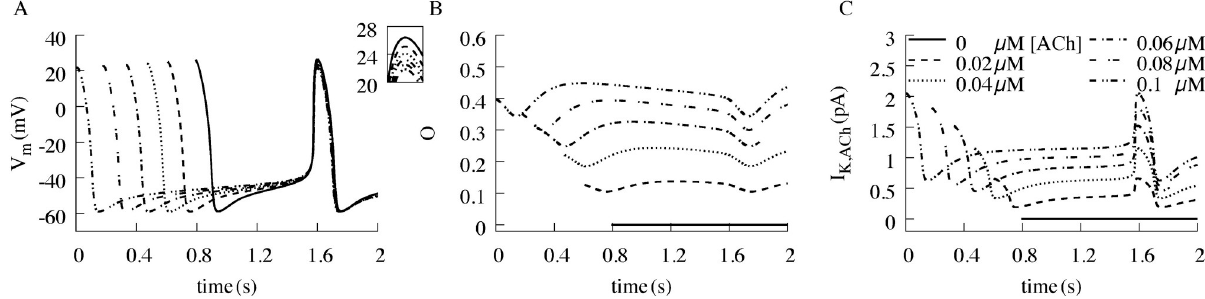
Fig 1. Simulation of the effect of varying amounts of ACh concentrations on sinus node properties. (A) Resulting transmembrane voltage (V m ) showing the increase in BCL from 827 ms to 1585 ms with a reduction of APD 90 by roughly 10%. (B) Open probability O of the channel and (C) the corresponding activated I K , ACh